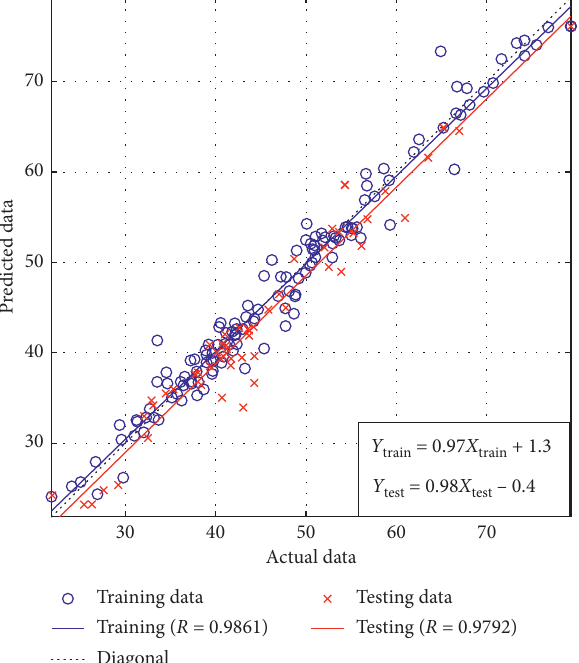
Figure 9: Regression graph for the training and testing datasets using the FNN